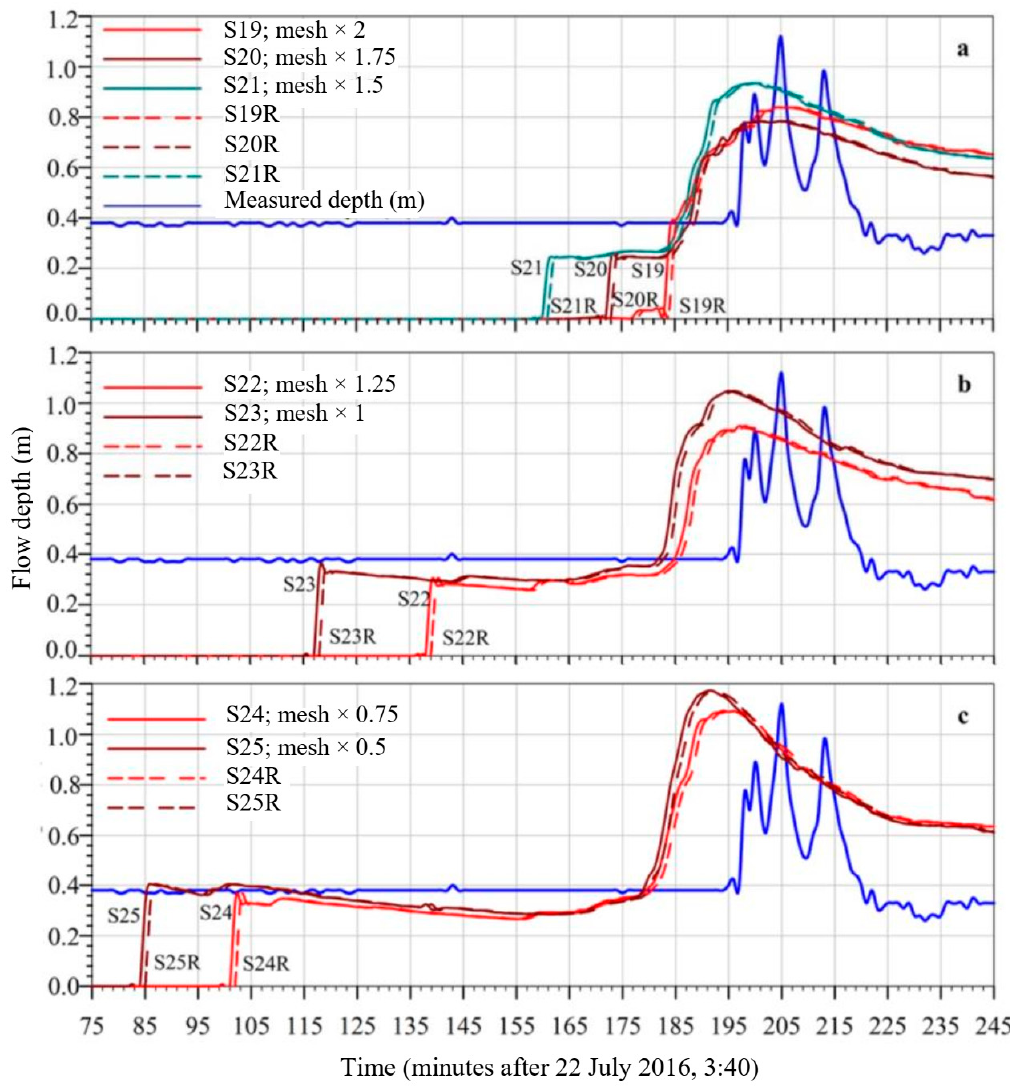
Figure 6. Analysis of the sensitivity of the numerical results to the average width of the triangular elements; Density = 1600 (kg/m 3 ); Manning’s coefficient = 0.055, CTY rheological model; YS = 5 (Pa); Angle 3°; k = 0.05 (s − 1 ); f c = 1.58 (m/s); f 0 = 7.06 × 10 − 6 (m/s); ( a ) comparison of simulations S19–S21 to their repeated runs S19R-S21R; ( b ) comparison of simulations S22–S23 to their repeated runs S22R–S23R; ( c ) comparison of simulations S24–S25 to their repeated runs S24R–S25R.